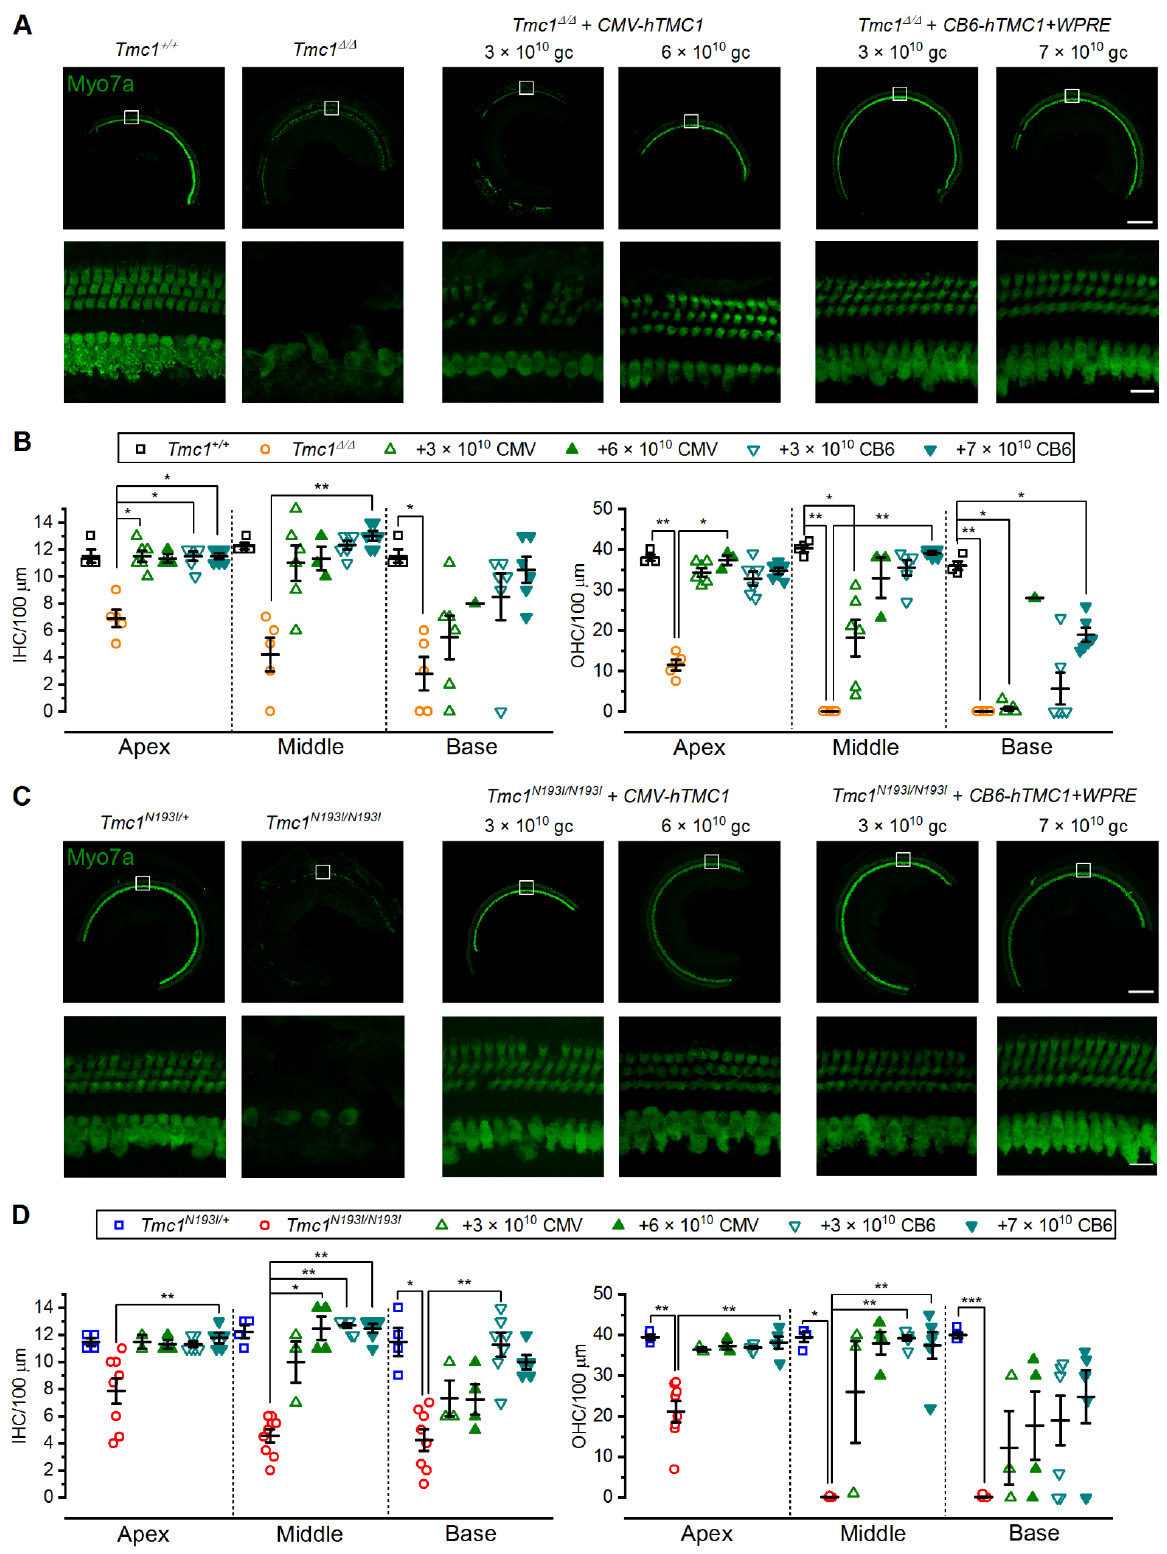
Figure 5. AAV2/9-PHP.B -hTMC1 gene therapy restores hair cells counts in mutant mice. ( A ) Repre- sentative confocal images from middle cochlear sections of Tmc1 +/+ , Tmc1 ∆ / ∆ and Tmc1 ∆ / ∆ injected with CMV-hTMC1 (3 × 10 10 or 6 × 10 10 gc) or CB6-hTMC1 + WPRE (3 × 10 10 or 7 × 10 10 gc)